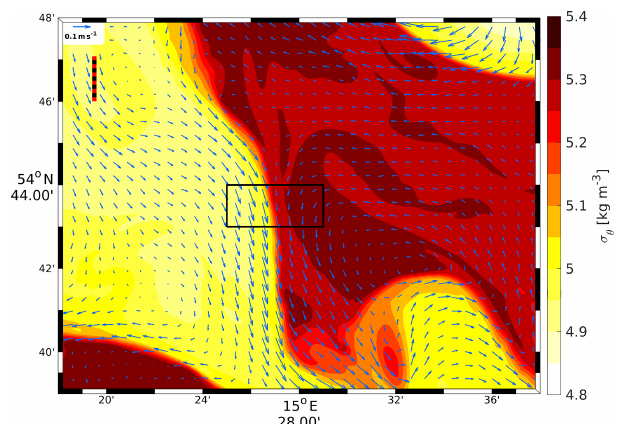
Figure 15. R100, 26 June: potential density anomaly σ θ in the top layer with total velocity V drawn at 600m resolution. For the posi- tion of the area, see the red box in Fig. 7d. The black box indicates the position of the maps shown in Fig. 16a–e. The dashed ruler rep- resents a distance of